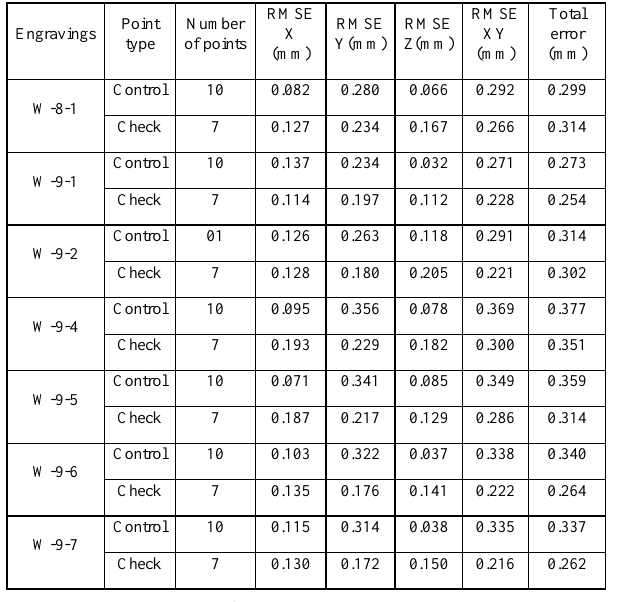
Table 1. The statistic of the RMSE values on control and check points - image orientation